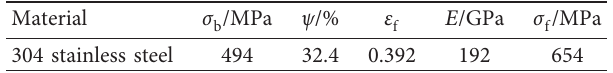
Table 2: Mechanical properties of 304 stainless